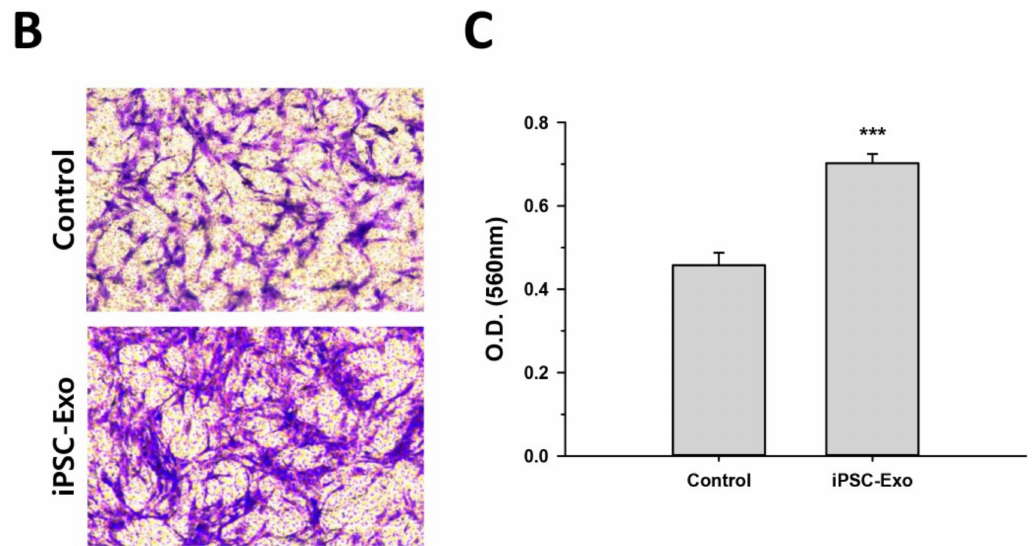
Figure 3. iPSC-Exo promoted the migration of HDFs. ( A ) Scratch wound assay for HDFs treated with iPSC-Exo. Serum-starved HDFs were scratched and simultaneously treated with 20 × 10 8 particles/mL iPSC-Exo. The representative image indicates more rapid migration of the iPSC-Exo-treated HDFs into the scratched area. ( B ) Representative image of a transwell assay for migration of HDFs. HDFs attached to the upper side of the transwell membrane migrated to the lower side in serum-free medium without or with iPSC-Exo for 24 h. The cells attached to the bottom of the membrane were fixed with 4% paraformaldehyde and stained with crystal violet. ( C ) Quantitative analysis of a transwell assay. Transwell membrane with the stained HDFs was cut out and immersed in a 50% acetic acid solution to dissolve the crystal violet. The amount of stained crystal violet was determined as absorbance at 560 nm. *** p < 0.001 compared to the iPSC-Exo-untreated group. Error bars indicate standard deviations of triplicate samples in a single representative